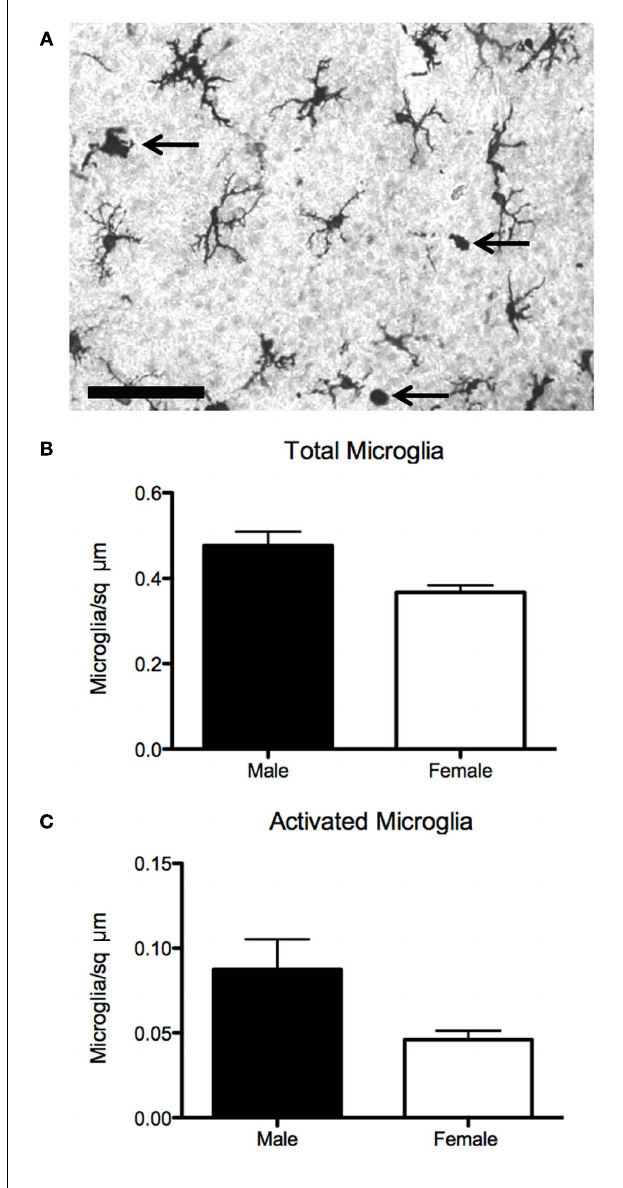
FIGURE 3 | Sex differences in microglia in the preoptic area. (A) Established sex differences in number and morphology of neurons and astrocytes in the preoptic are being joined by sex differences in microglia, the brain’s resident immune cell. (B) Males have more microglia than females on postnatal day 2, when stained for the microglial marker Iba1. (C) Males also have more activated, ameboid microglia (arrows in 3A), which are associated with secretion of prostanoids, cytokines, chemokines, as well as phagocytosis. Scale bar = 50 μ